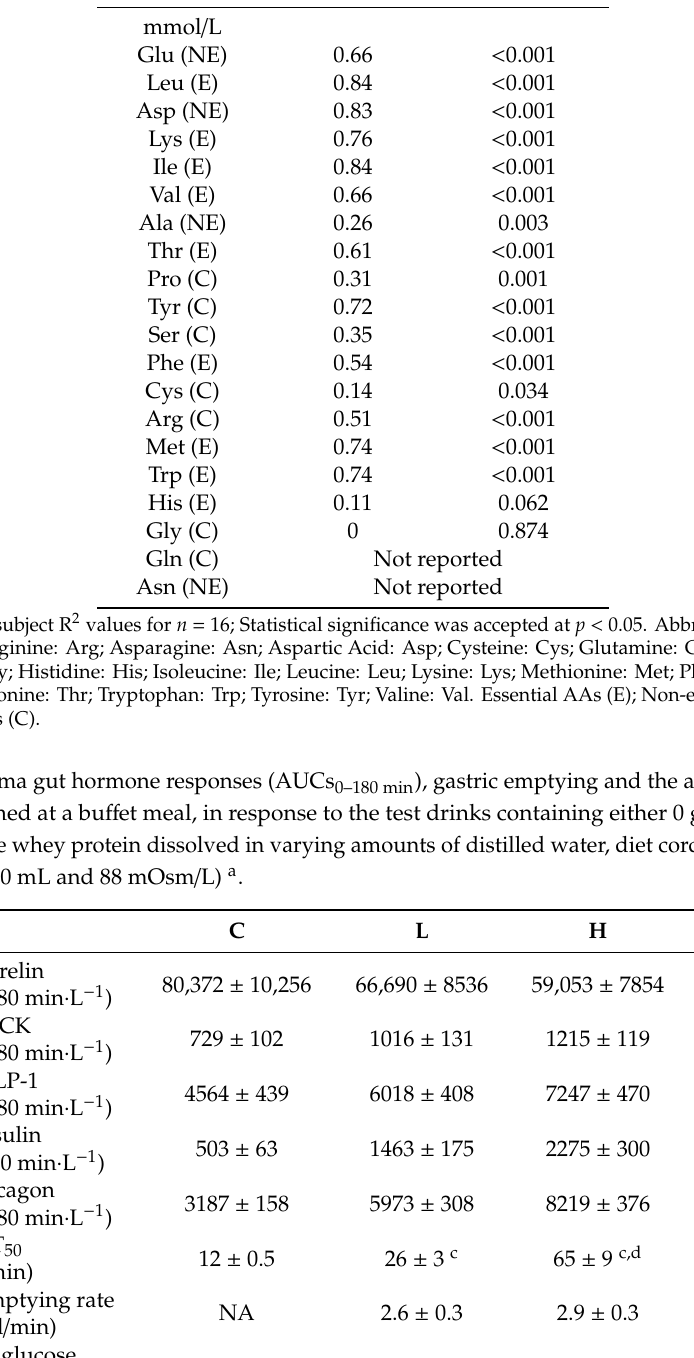
Table A2. Within-subject relationships between the iAUCs 0–180 min of each of the 20 amino acids (displayed in order of abundance of the amino acids within the whey protein drinks) with the load of protein, following consumption of the test the drinks containing either 0 g (C), 30 g (L) or 70 g (H) of pure whey protein dissolved in varying amounts of distilled water, diet cordial and sodium chloride (all 450 mL and 88 mOsm / L). AA R 2 Value P Value mmol / L Glu (NE)